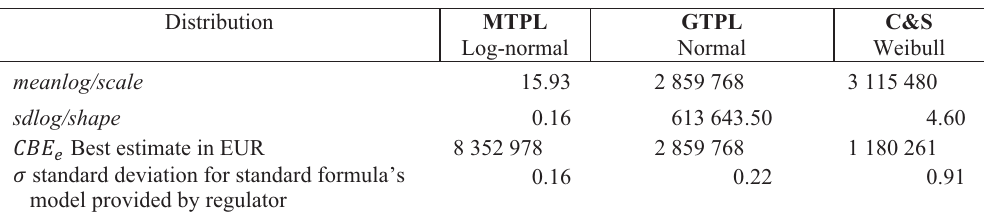
Table 1. Unique distributions, parameters and claims best